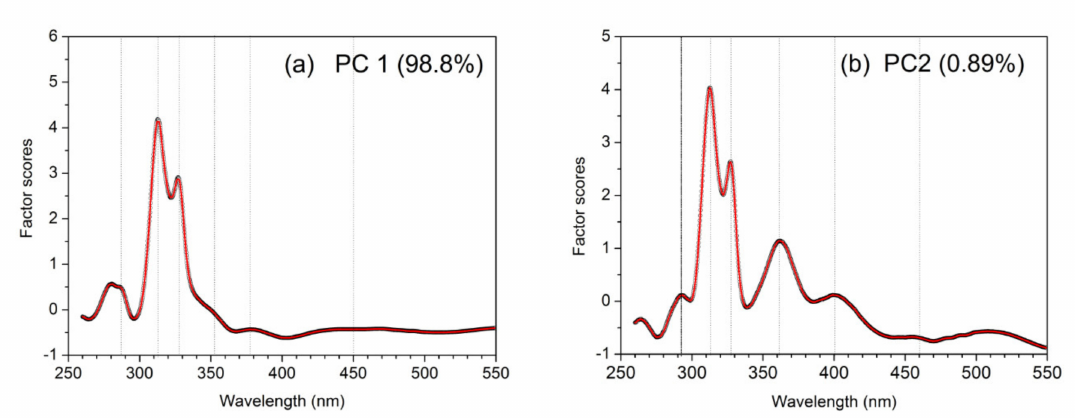
Figure 3. Scores plots of principle component 1 (PC1) ( a ) and principal component 2 (PC2) ( b ) for spectral wavelengths in UV / O 3 system.